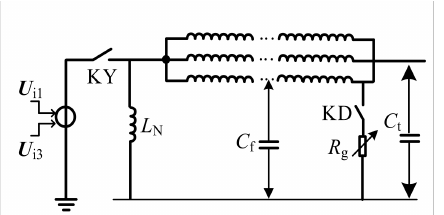
Figure 6. Wiring diagram of the dynamic experimental system.